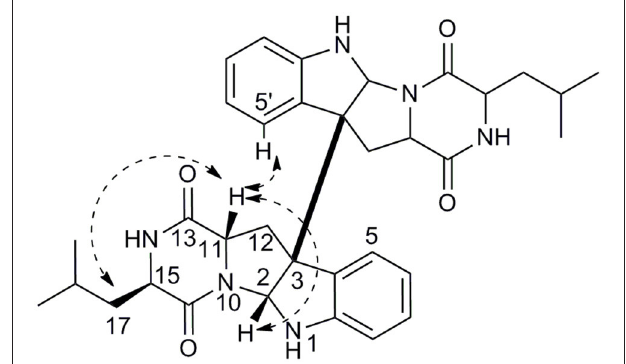
FIGURE 6 | Key NOESY correlations of 3